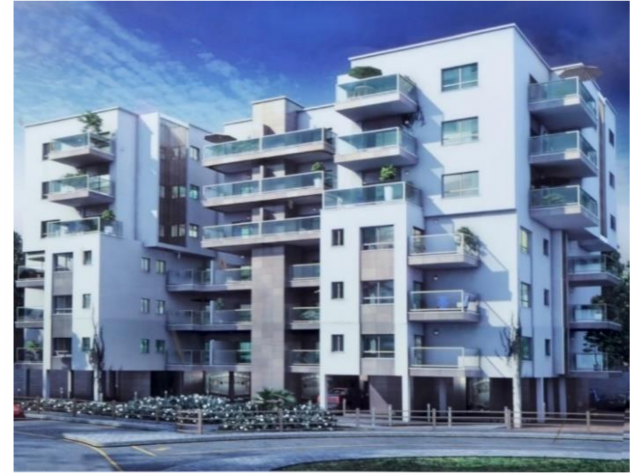
Figure 6. Simulation of the first redeveloped building, photographed by the authors, 2012.